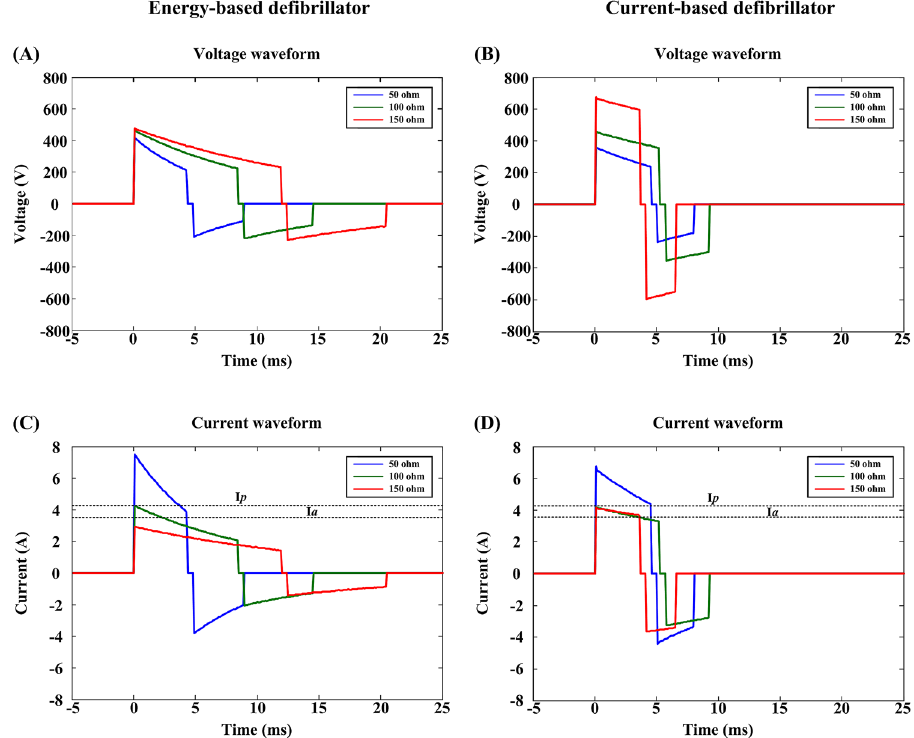
Figure 2. Defibrillation voltage ( A , B ) and current ( C , D ) waveforms of current-based and energy-based defibrillations for a 10 J test shock when the pathway impedance was 50, 100 and 150 ohms respectively. I a and I p indicate the target average and peak currents described in Eqs. (1) and (4).